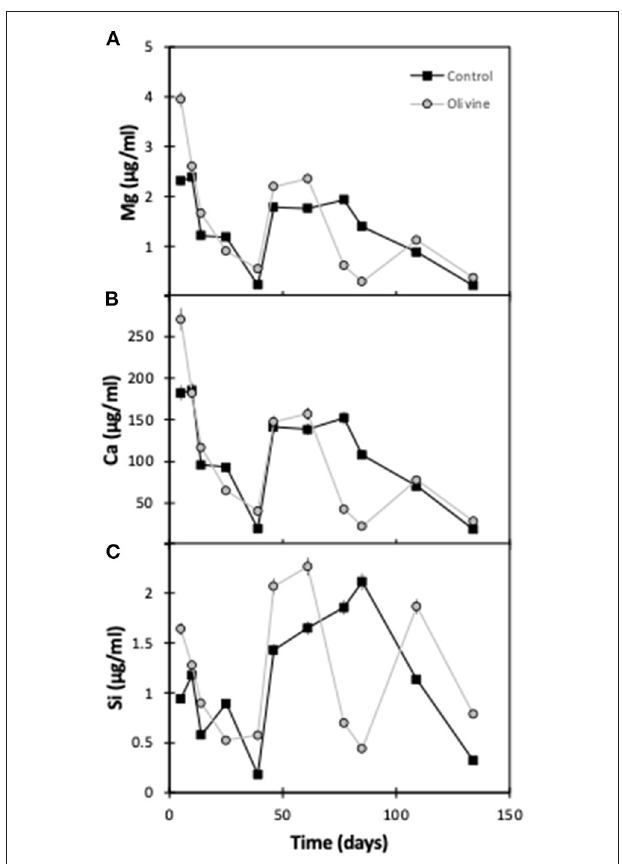
FIGURE 2 | Effluent major element concentrations as a function of experimental time for both columns: (A) magnesium, (B) calcium, (C) silicon. The error bars represent the 2sd analytical